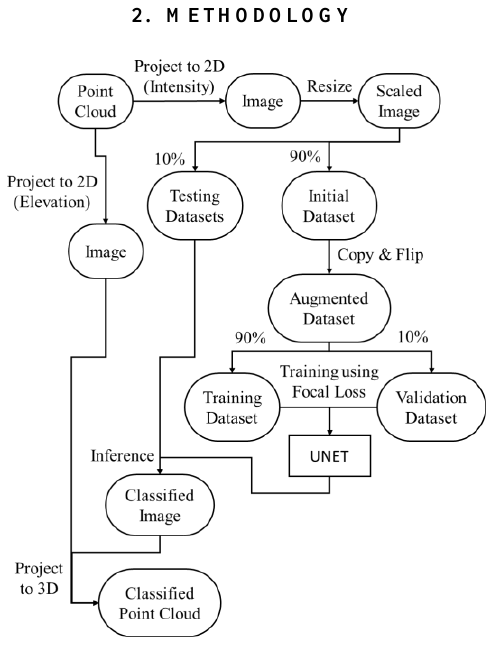
Figure 1. Proposed